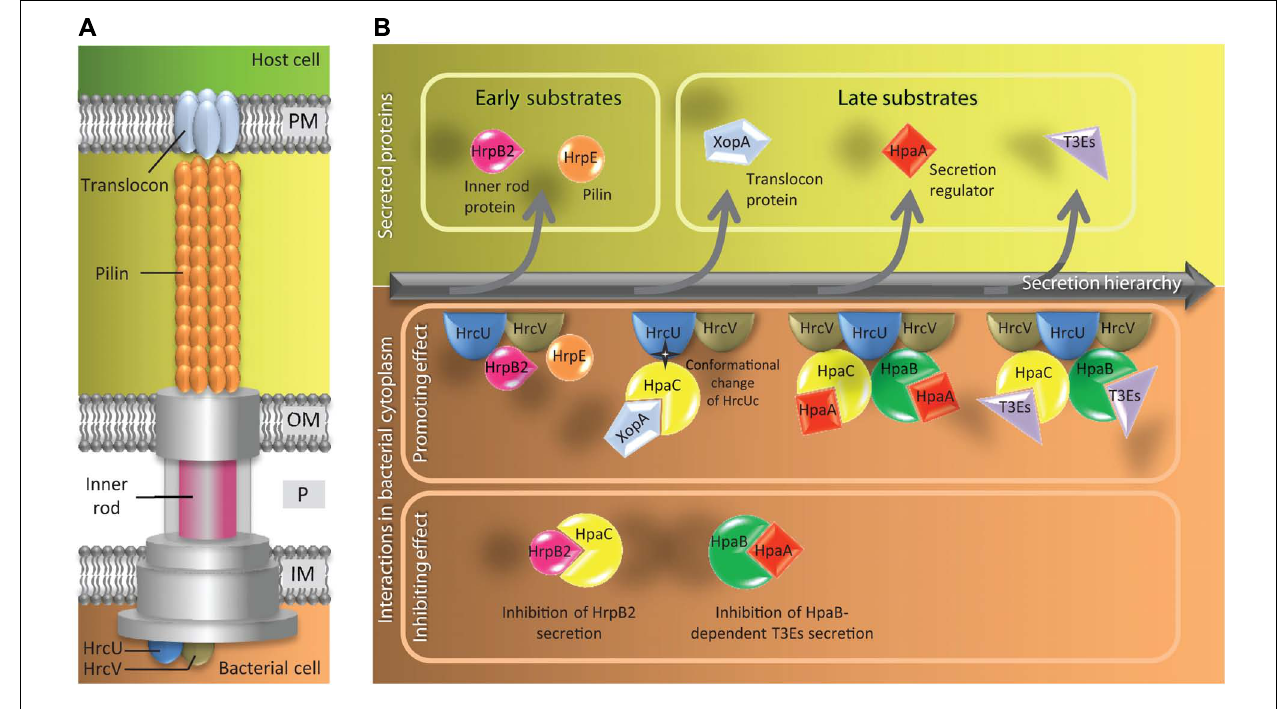
FIGURE 2 | Model of the control of type III secretion hierarchy in X. campestris pv. vesicatoria . (A) Schematic representation of theT3SS highlighting components mentioned in (B) .The basal body of theT3SS spans the inner membrane (IM), the periplasm (P) and the outer membrane (OM) of the bacterium.The extracellular part of theT3SS comprises pilin subunits that form the pilus and translocon proteins that form a pore in the host plasma membrane (PM).The outer membrane/periplasmic inner rod is presumably the intracellular prolongation of the pilus. HrcU and HrcV are inner membrane components with a cytoplasmic C-terminal part. (B) Schematic view of the secreted proteins (upper part) and the protein interactions involved (lower